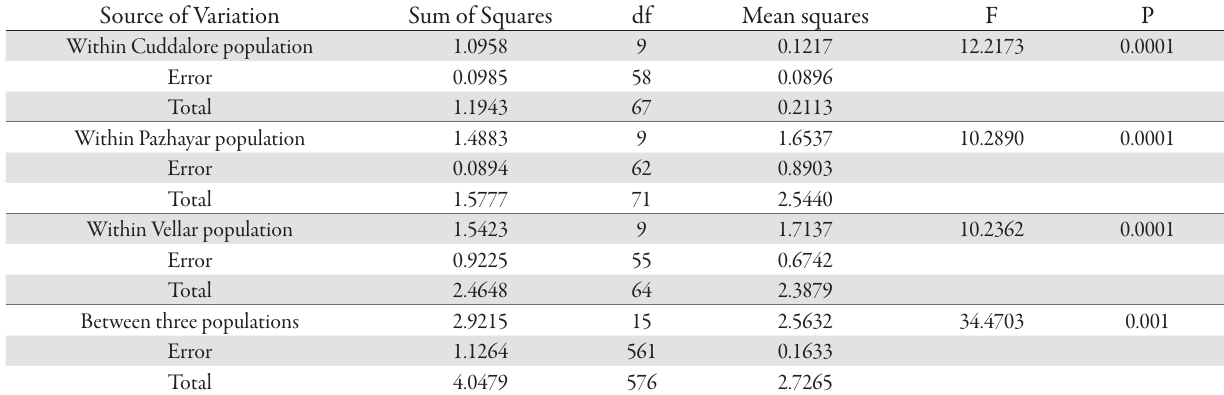
calculated based on RAPD markers among the three populations